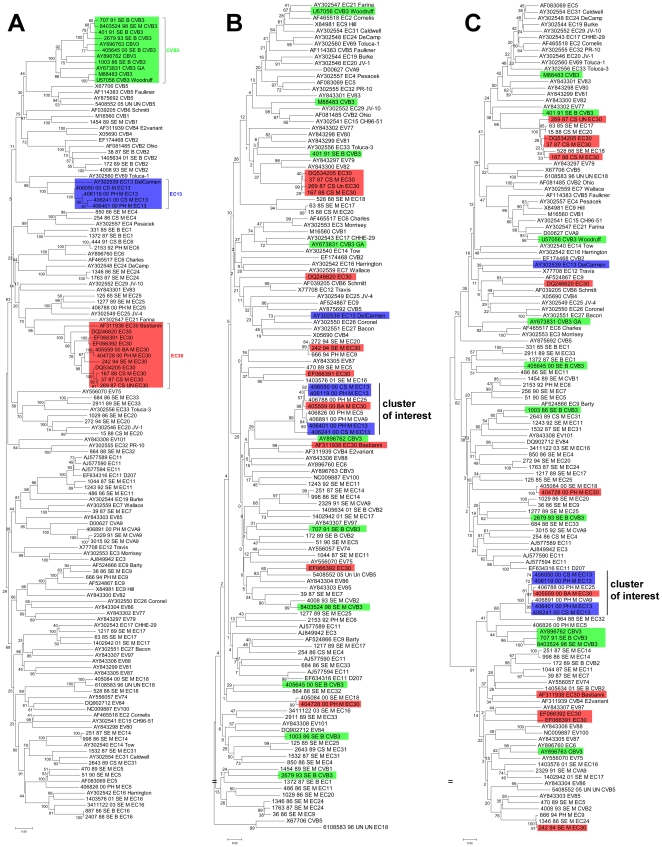
Phylogenetic trees of HEV-B in the VP1 (A), 2C (B) and 3D (C) regions.Inconsistent topologies suggest possible recombination events, especially in the case of E30 (red) and CVB3 (green). E13 clinical isolates (blue) however, differed little genetically across the genome, suggesting the absence of major recombination events. Our cluster of interest includes 7 strains (4 E13, 1 E30, 1 CVA9 and 1 E25) that group reliably (bootstrap 100%) in the 2C and 3D regions but not in the VP1 region.